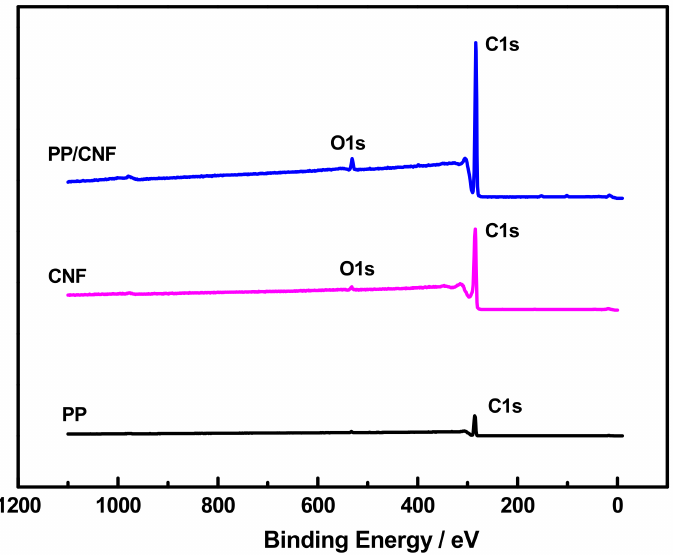
Figure 4. XPS survey spectra of PP, CNF powder, and PP/5 wt.% CNF composite.